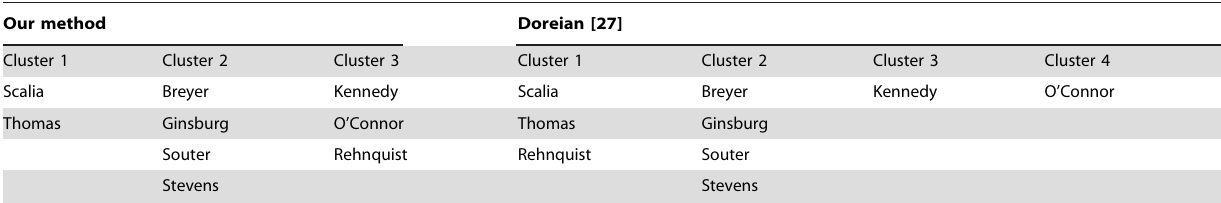
Table 4. Justice